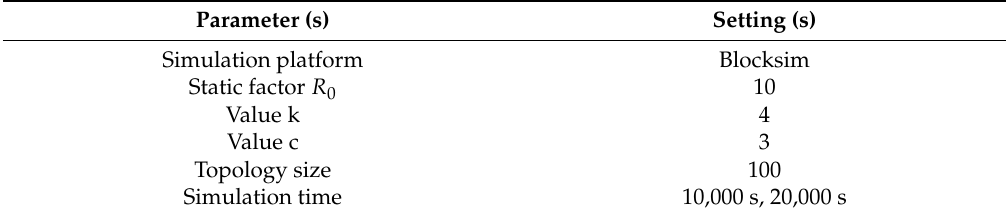
Table 5. Parameters in experiment